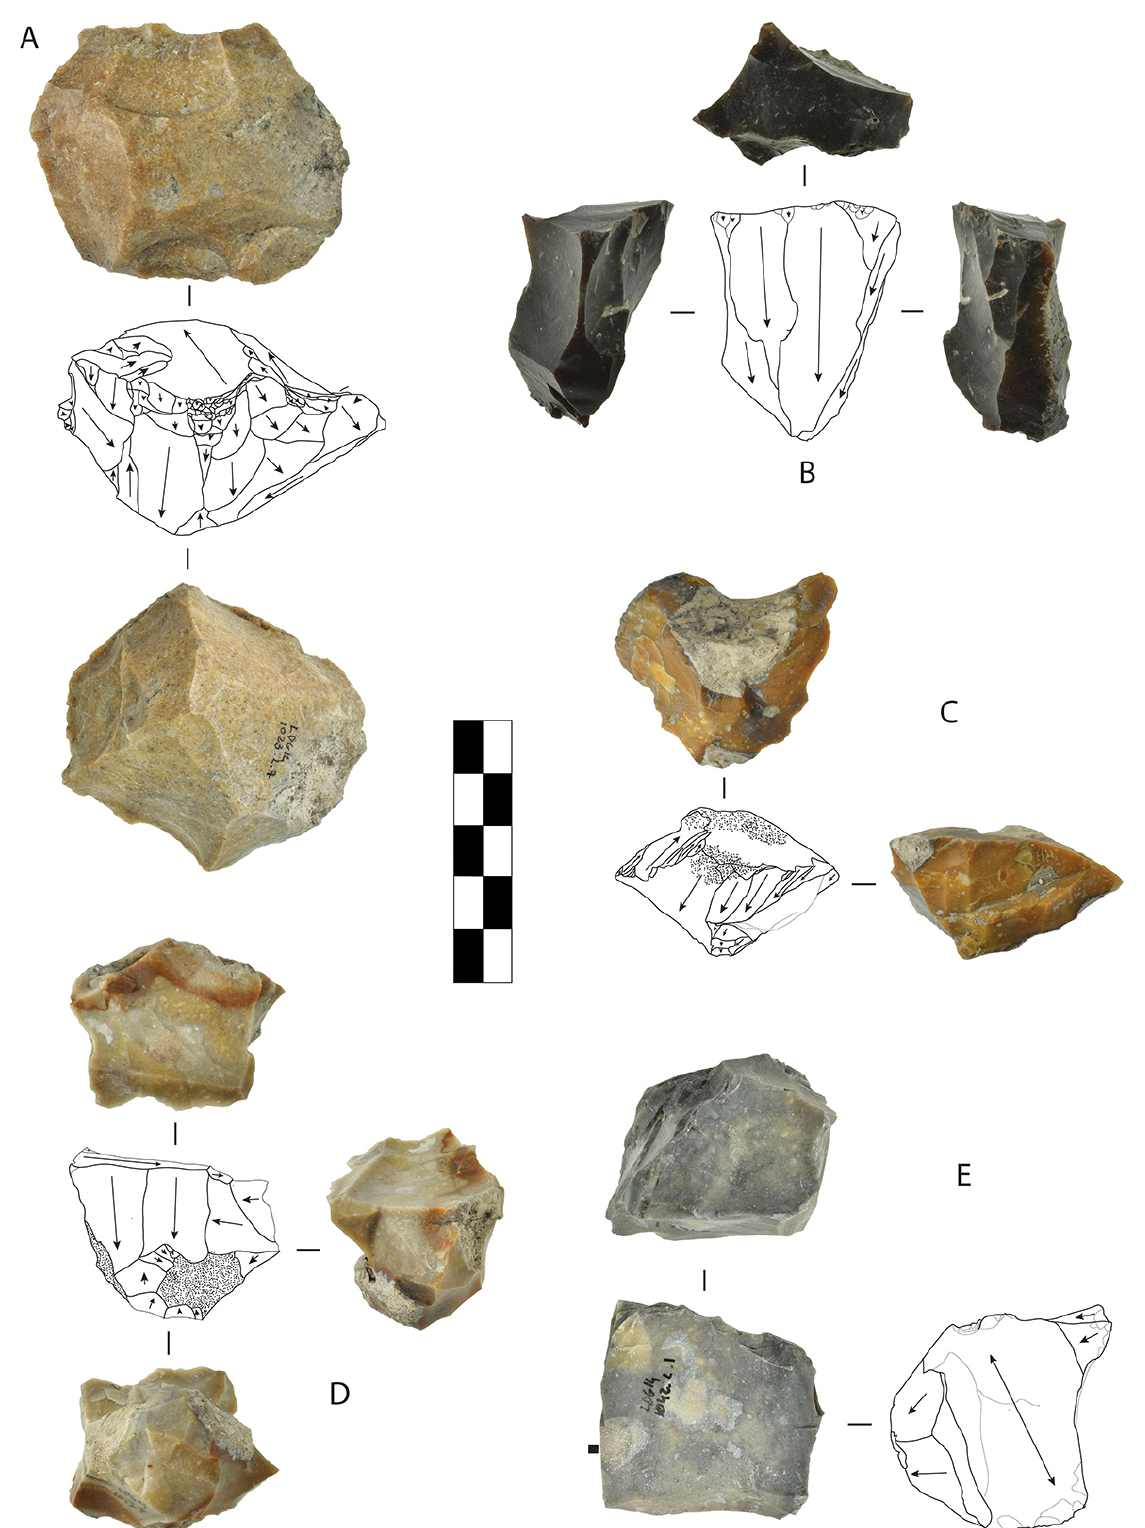
Figure 3. Core assortment of LDG with diacritic schemas: Middle Neolithic A and E: A, freehand bifacial model, E bipolar multidirectional model; Late Neolithic cores B, C and D: B freehand unidirectional model, C, freehand subsequent model, D freehand